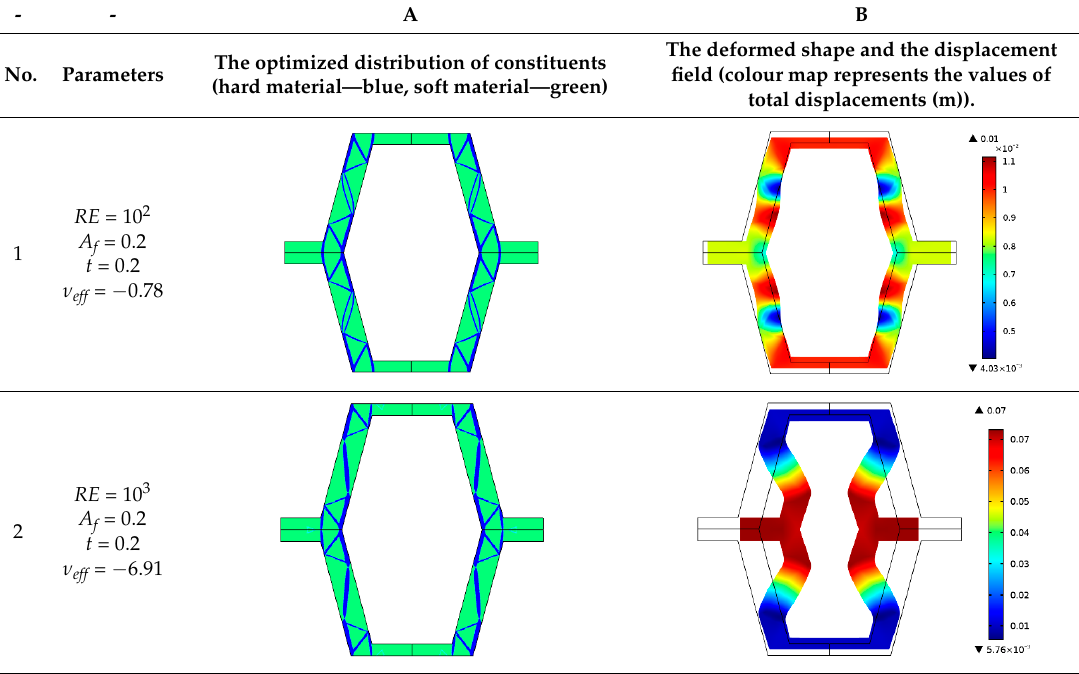
Table 2. Results of honeycomb topology optimization. Parameters of each case, the optimized distribution of constituents, and the deformed shape of a vertically compressed shape. The deformed shape and the displacement field (colour map represents the values of (hard material—blue, soft material—green) total displacements